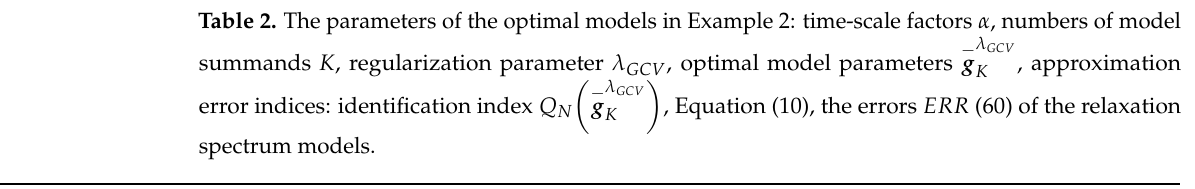
Table 2. The parameters of the optimal models in Example 2: time-scale factors α , numbers of